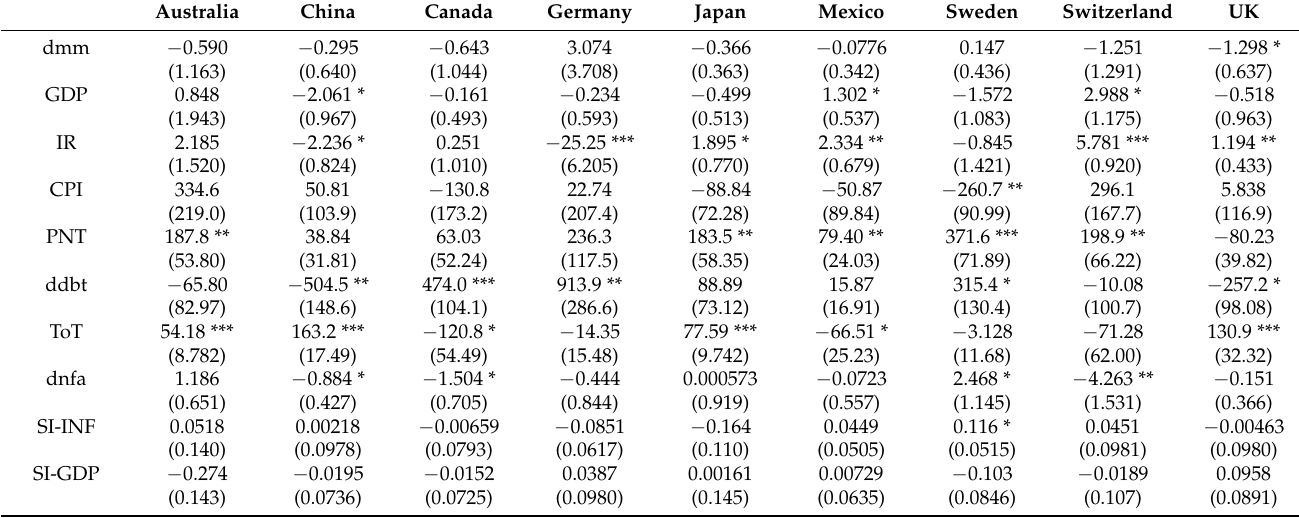
Table A23. Panel Regression AM Model with SI for